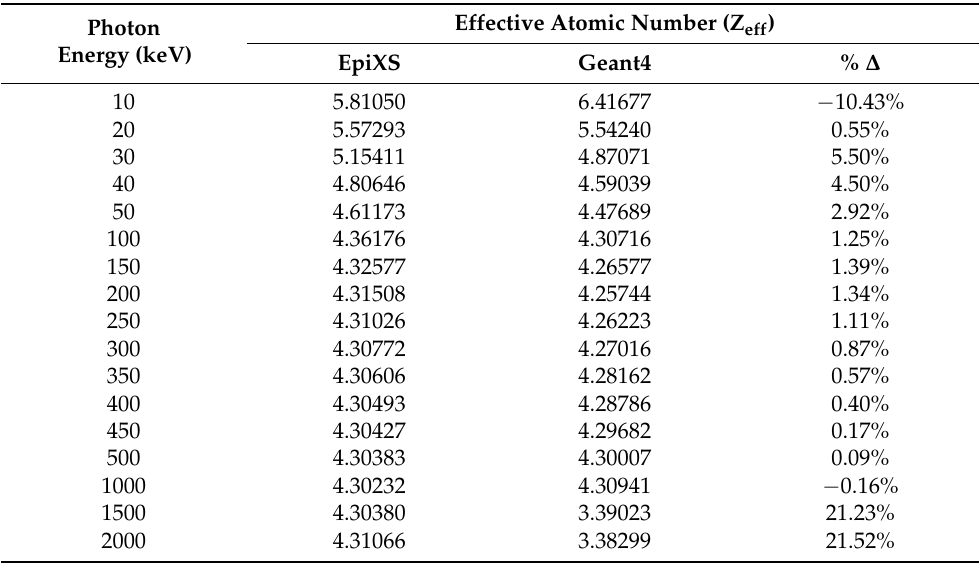
Table 2. The effective atomic number of the investigated Polyimide was found by EpiXS and Geant4.